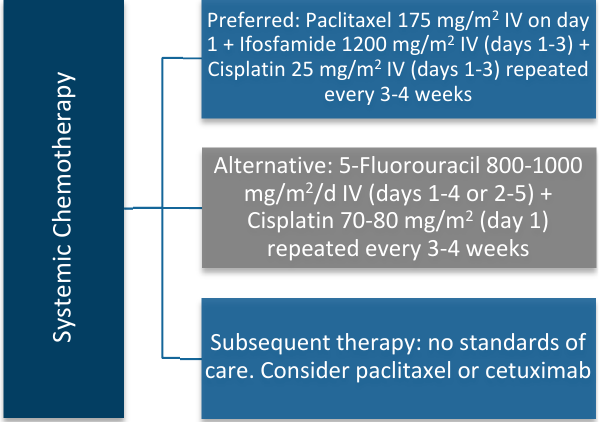
Figure 2. Current regimens in metastatic penile